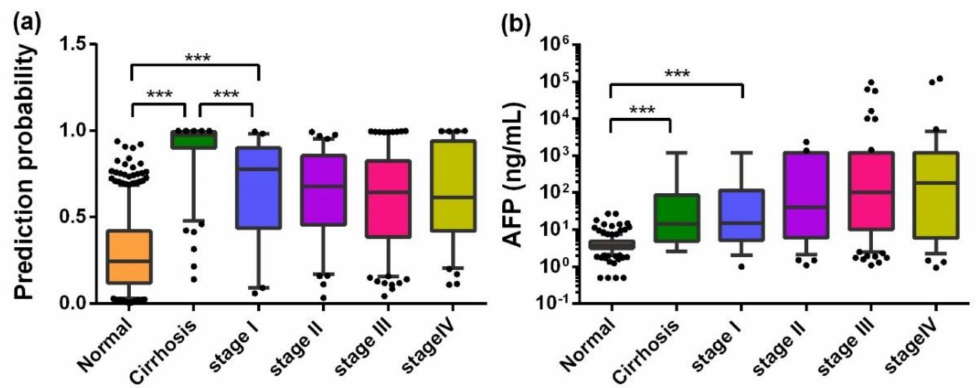
Figure 5. Box plots of PP ( a ) and AFP ( b ) in di ff erent stages in the development of HCC. Lines on the boxes are in the order of 95, 75, 50, 25, and 5 quantiles from top to bottom; Whiskers indicate points greater than the 95% quantile and less than 5% quantile; *** p <